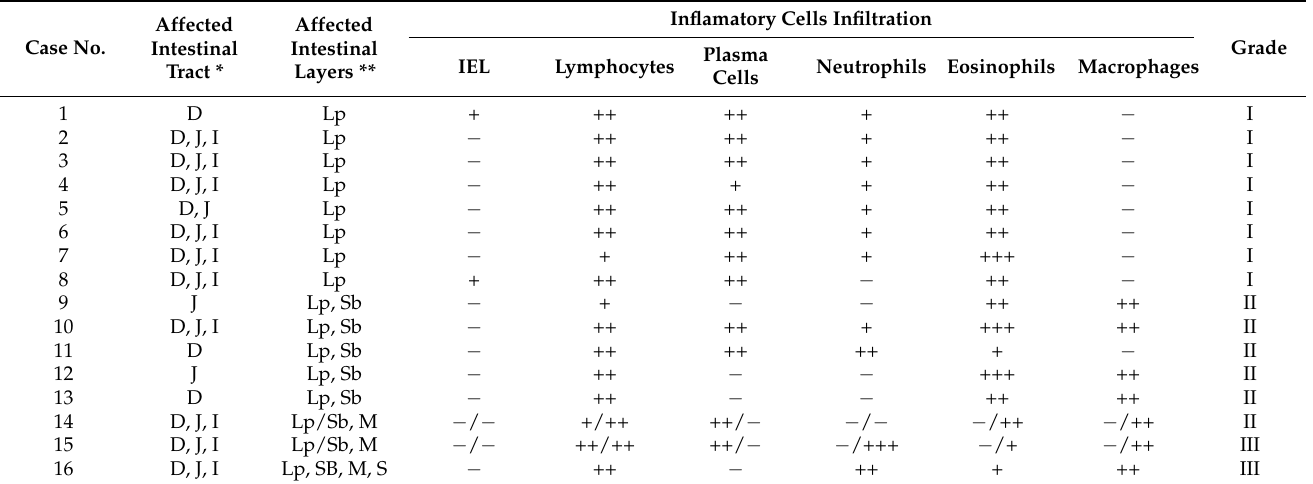
Table 6. Results of the histopathological evaluation and grade. Relation between inflammatory parameters with the affected layers and the grade of